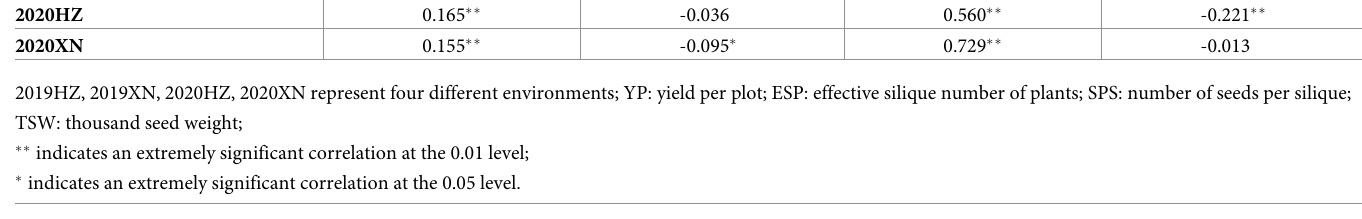
TSW: thousand seed weight; �� indicates an extremely significant correlation at the 0.01 level; � indicates an extremely significant correlation at the 0.05